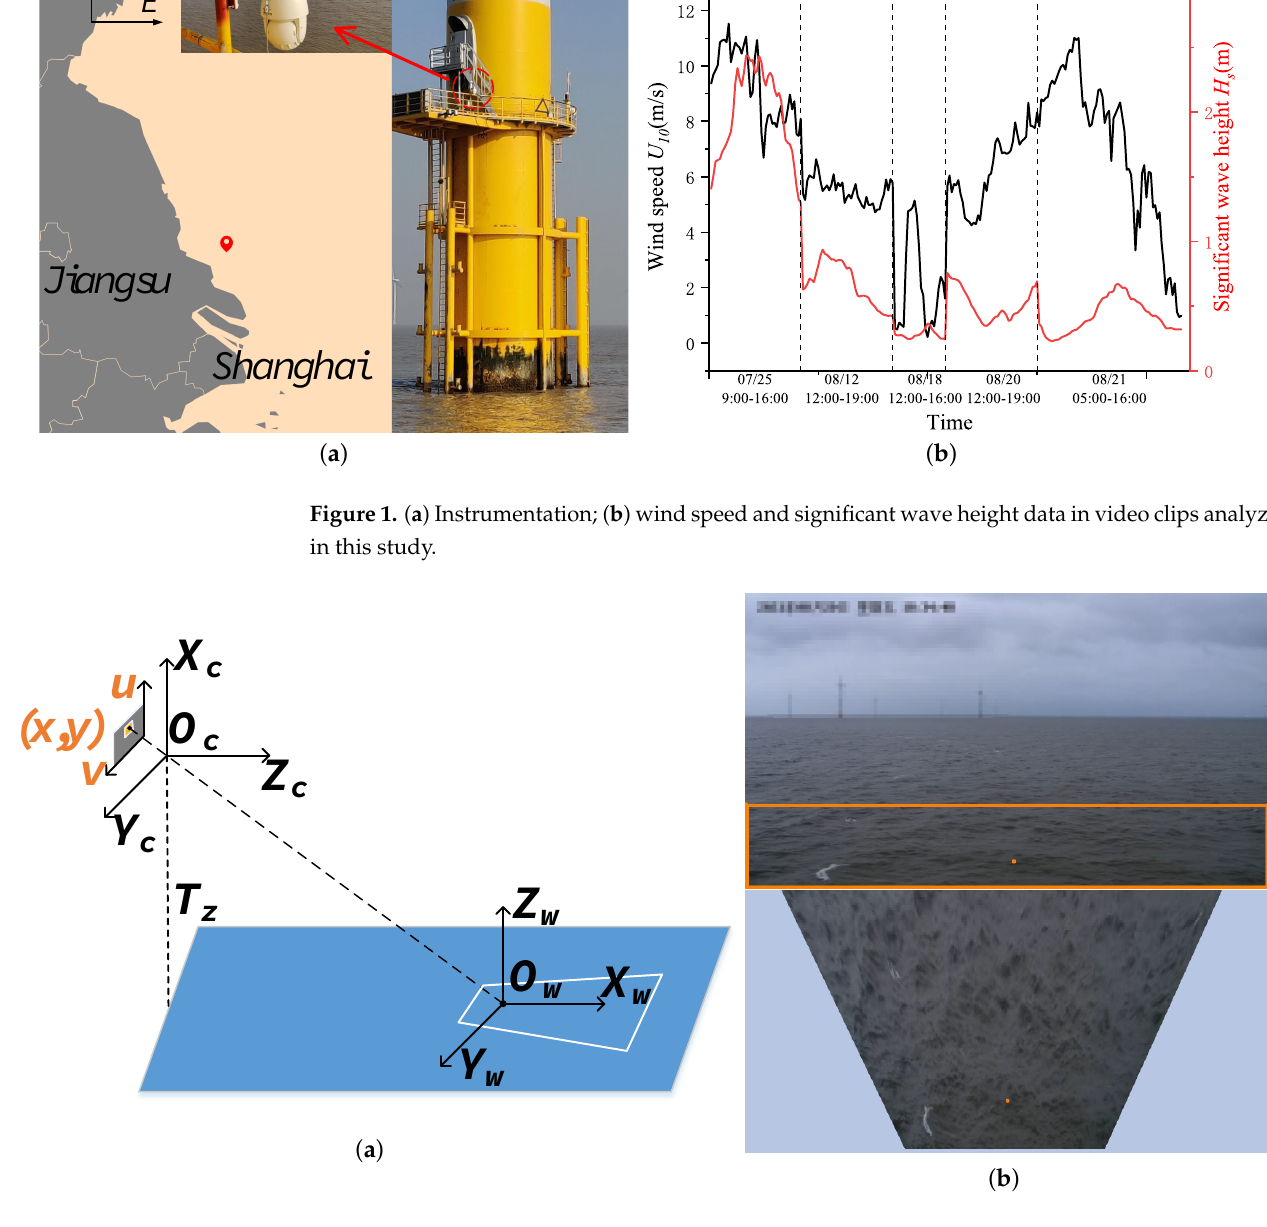
Figure 2. ( a ) The spatial location of the WCS and the PCS. ( b ) The original image taken by the camera and the image restored to WCS. The orange box marks the area restored to WCS, and the orange points in two images are the corresponding positions of the origin coordinate in the WCS. The spatial size of the image under the WCS is 50.00 m × 85.69 m, with the same spatial resolution in both